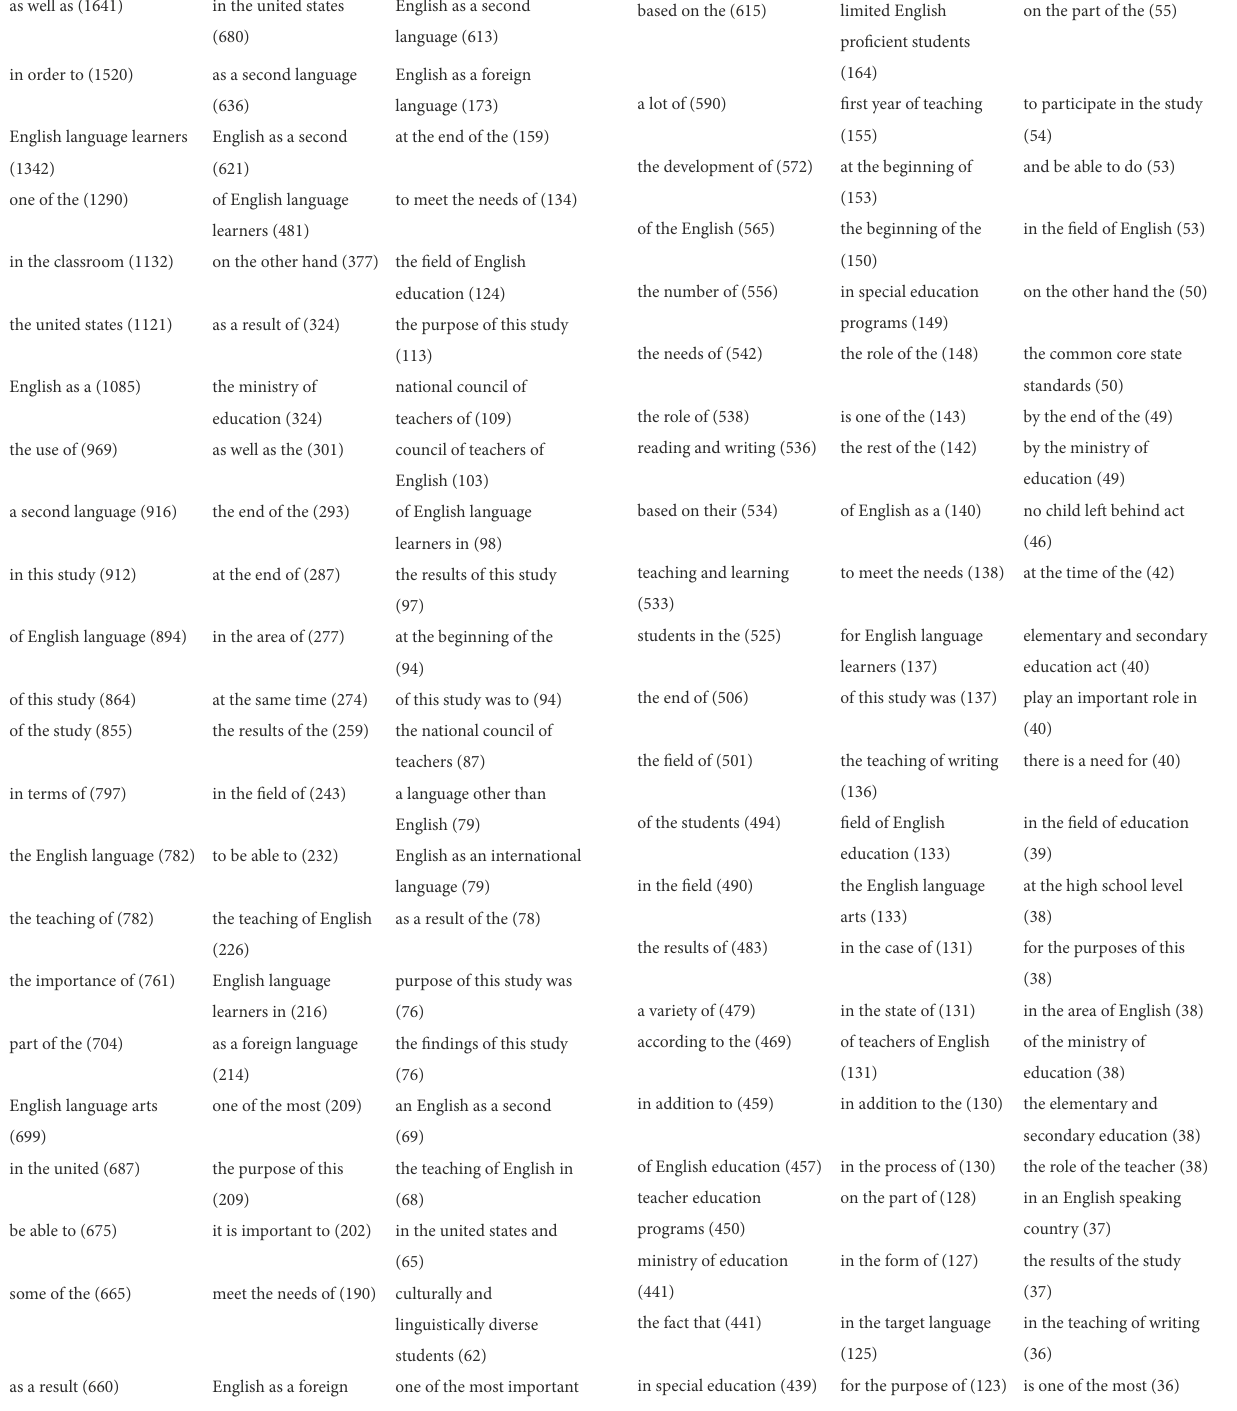
TABLE 3 The top 50 three-, four-, and five-word